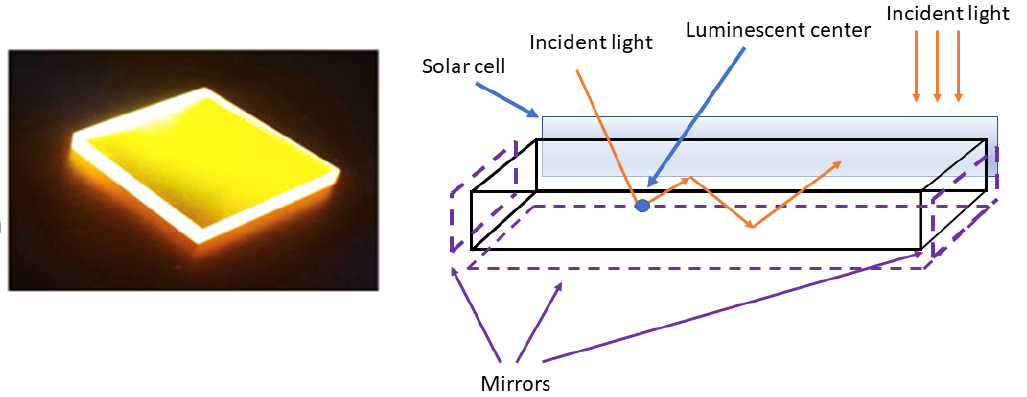
Figure 9. The idea of the LSC cell and the prototype of the luminescence layer with guided light direction and monochromatic emission, based on [126].